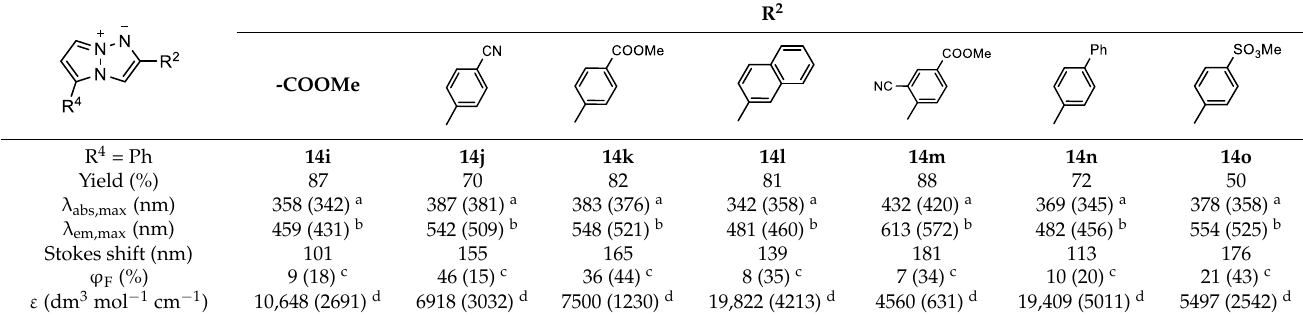
Table 5. Fluorescence properties and reaction yields of 2-substituted 4-phenyl-TAPs 14i–o in DCM.